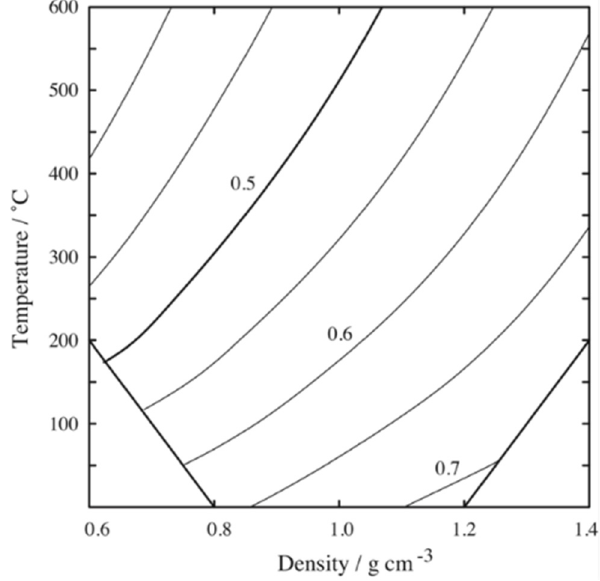
Figure 10. Deviation of the dipole moment relative to values in the isolated molecule (shown in Debye units). This figure is reprinted with permission from JCP , 1999 , 111 , 8545. Copyright 1999 AIP Publishing.